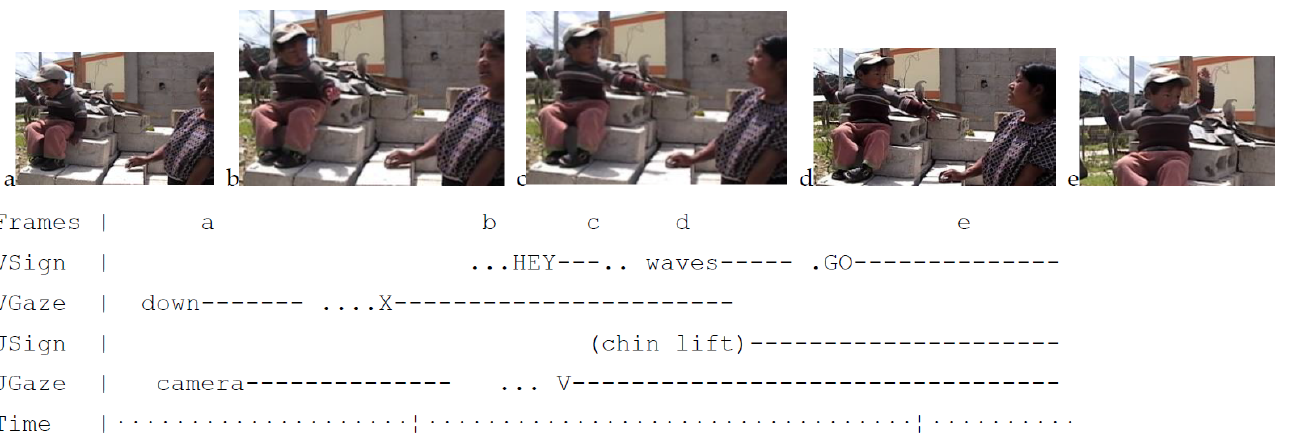
Figure 19. Victor at 23 months started to ask his mom if they could go to hear a band. As the band marched off, ( a ) Vic sat on a pile of cinderblocks holding his right hand on a clothesline. He then ( b ) turned to his mother, who was looking elsewhere, and raised his left hand ( c ) to make a quick HEY1 gesture, with ( d ) two tiny final downward flips of the hand which attracted Jane’s gaze. Jane had raised her chin in an interrogative head tilt to acknowledge that she was paying attention. Vic then ( e ) began a substantive turn, signing “Let’s go”, and going on to tell her that he wanted to follow the band to continue to listen to it.